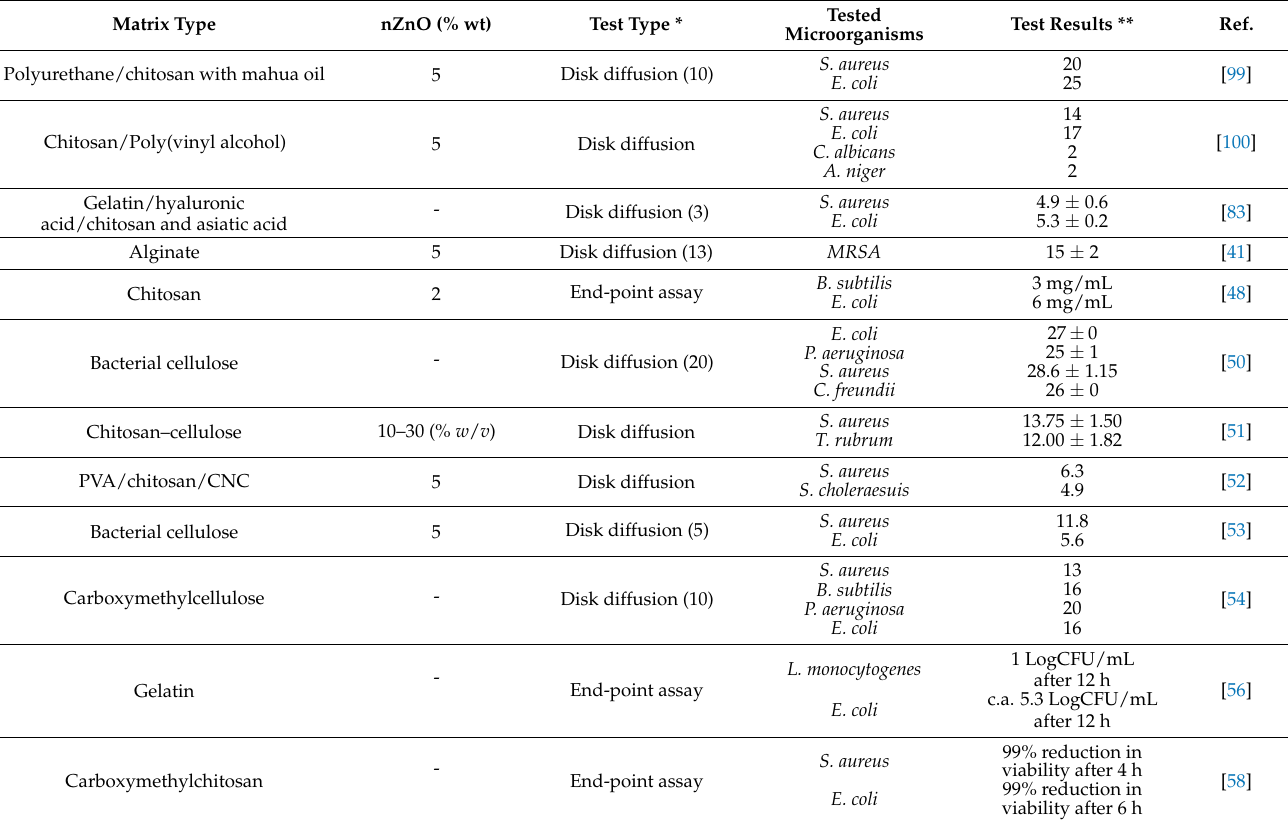
Table 4. Antimicrobial efficacy of different nZnO-BNCs against different strains measured either via disk-diffusion tests or end-point